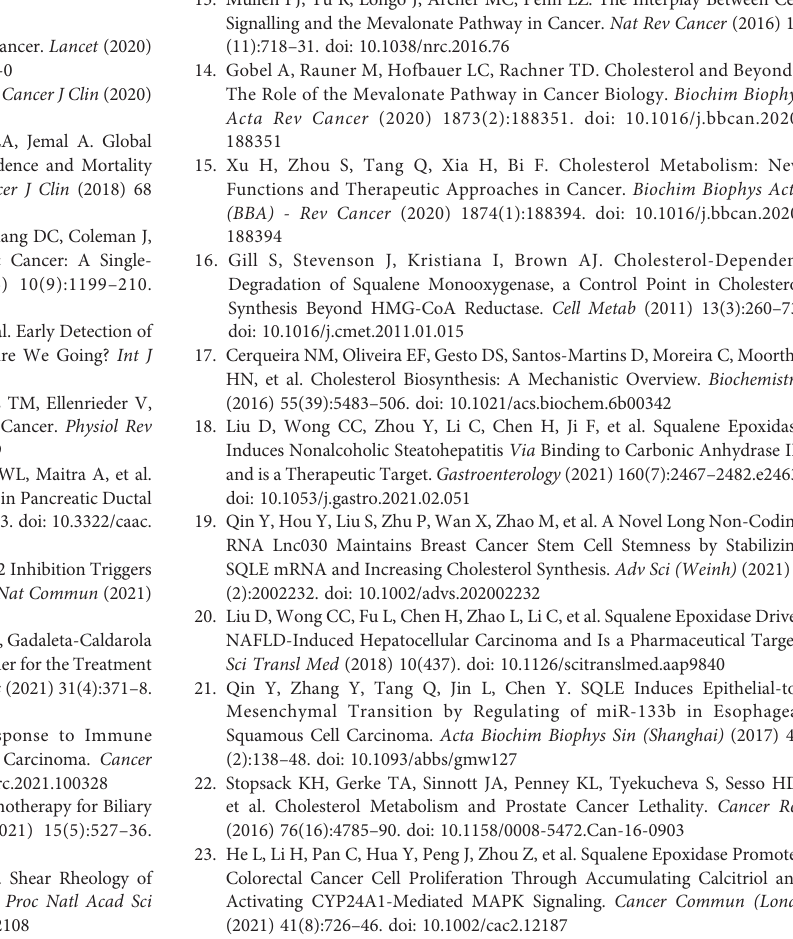
Supplementary Figure 1 | Disease-free survival (DFS) analysis for SQLE in multiple human cancers. (A – G) DFS curves of SQLE in ACC (A) , BLCA (B) , HNSC (C) , LUSC (D) , PAAD (E) , SARC (F) , and UVM (G) . Supplementary Figure 2 | SQLE expression, copy number, and methylation are associated with tumor immune features. (A – D) Correlation of SQLE with lymphocyte (A) , immuno-inhibitor (B) , MHC molecule (C) , and immunostimulator (D)